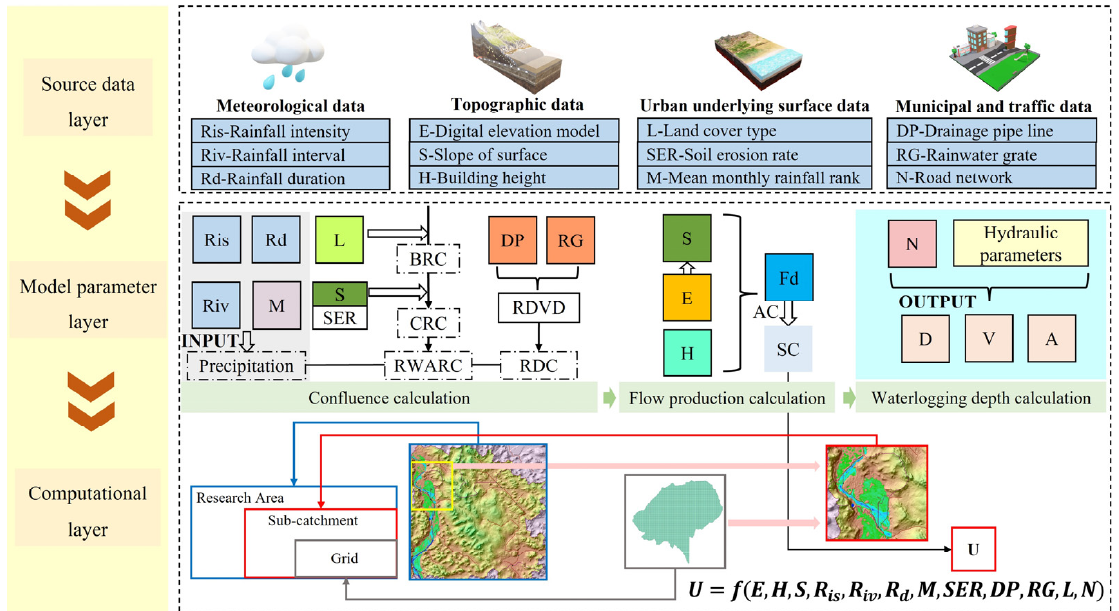
Figure 1. MDF-H Framework: where U is the unified fusion parameter, E is the elevation, R is is the rainfall intensity, R iv is the rainfall interval, R d is the rainfall duration, H is the building height, S is the slope, F d is the flow direction, L is the land cover type, N is the road network, DP is the drainage pipes, RG is the rainwater grate, SC is the sub-catchment, M is the mean monthly rainfall rank, SER is the soil erosion rate, BRC is the basic runoff coefficient, CRC is the comprehensive runoff coefficient, RWARC is the regional weighted mean runoff coefficient, RDC is the regional drainage coefficient, D is the waterlogging depth, V is the runoff flow velocity, and A is the area of SC . The data descriptions and sources used in this framework in the case study refer to Table 2. Table 2. Data sources and data resolution accuracy corresponding to each factor involved.